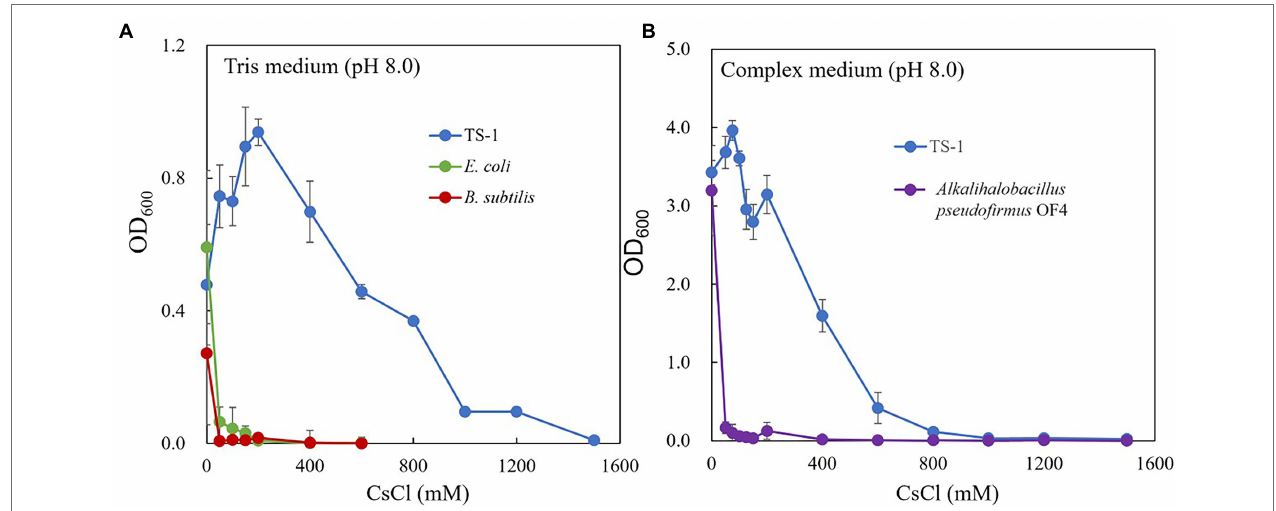
FIGURE 1 | Cs + resistance growth test of strain TS-1. The growth of strain TS-1 on Tris medium (pH 8) was compared to that of Escherichia coli and Bacillus subtilis at several CsCl concentrations (A) . The growth of strain TS-1 on a NC medium (pH 8.0) was compared to that of strain OF4 at several CsCl concentrations (B) . Reciprocally shaking culture was performed at 30 ° C at 200 rpm for 24 h, and the OD 600 was measured. Three independent experiments were performed. Error bars indicate